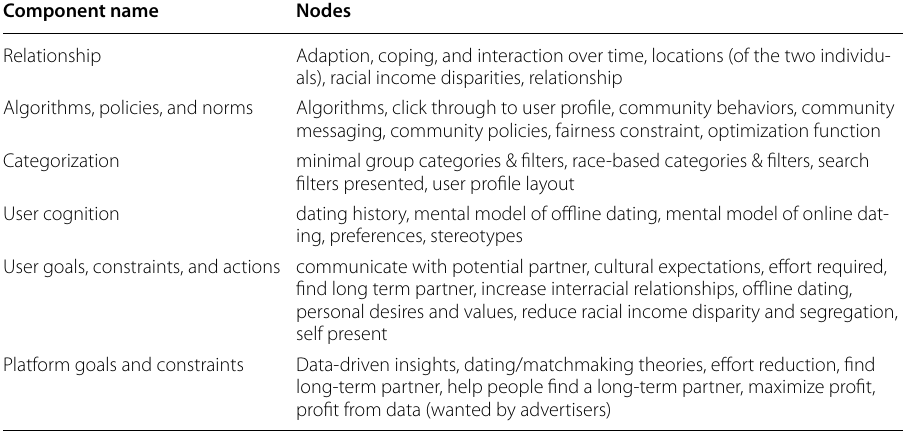
The left‑hand column represents a name we construct to refer to each cluster in the text; on the right, the nodes in the